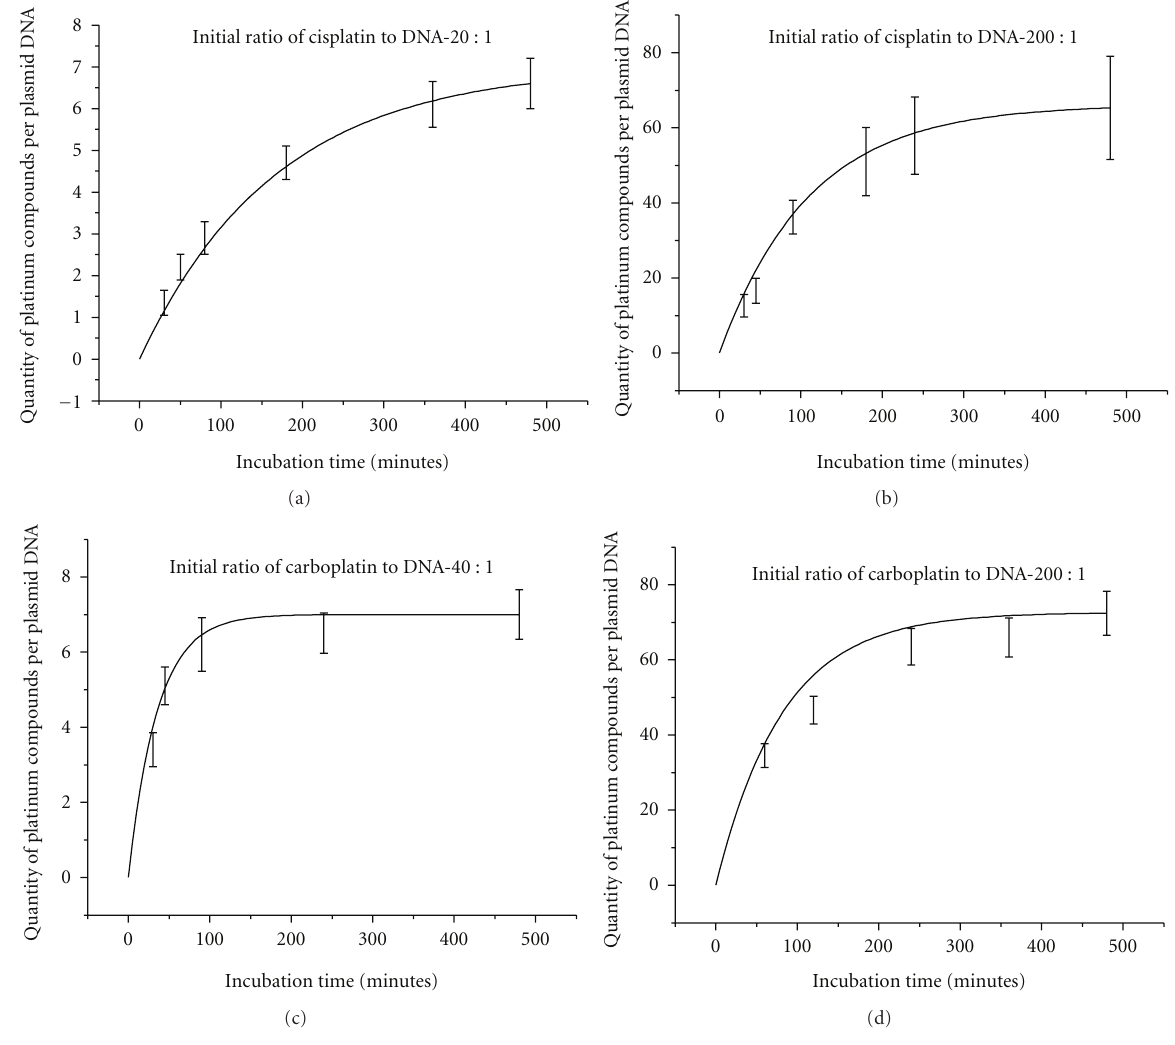
Figure 2: Kinetics of binding of Pt compounds to plasmid DNA. The Pt compounds are: (a) cisplatin with the initial ratios in the solution of 20 :1, (b) 200 :1, and (c) carboplatin with the initial ratios of 40 :1 and (d) 200 :1. The curves show the quantity of bound Pt compounds per DNA molecule at di ff erent incubation times at 25 ◦ C. Data in (a)–(d) are means from three measurements; error bars show standard deviations. The continuous black lines are exponential fits to the